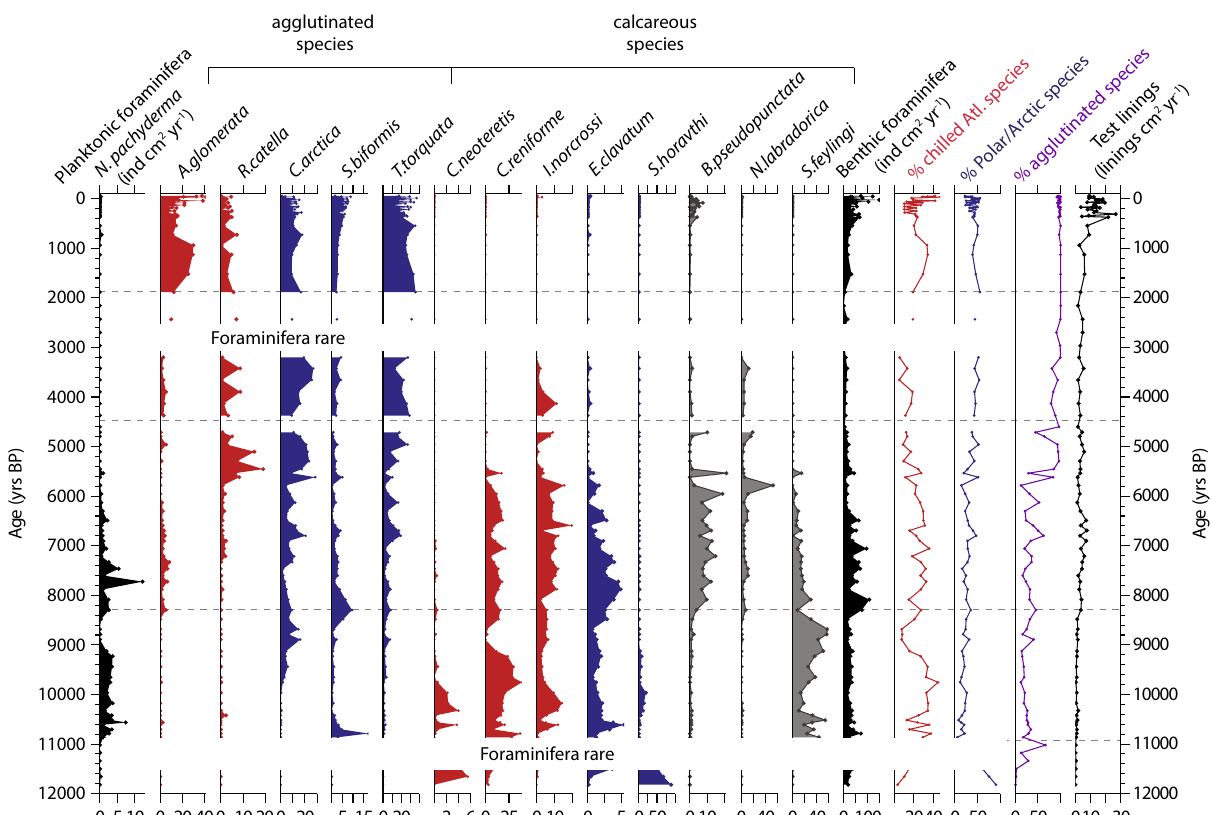
Figure 5. Foraminifera fluxes and assemblages in 117Q and 117Q BC. Planktonic foraminifera ( N. pachyderma sin.) fluxes are shown in black. Benthic foraminifera assemblages are show as percentage of the entire assemblage and colour coded according to Table 2. Only species that account for > 5% of the total assemblage in at least 1 sample are shown. Total benthic foraminifera fluxes (black) are shown as well as the overall (agglutinated and calcareous) % of chilled Atlantic water (red) and Polar/Arctic (blue) indicator benthic foraminiferal fluxes were ~ 150 ind cm 2 yr −1 , with the chilled Atlantic water group representing ca. 40% of the assemblage. Agglutinated taxa (Fig. 5) represented between 16–35% of the total benthic foraminifera assem- blage between ~ 11,900 and 8300 yrs BP, with the exception of a peak contribution (70%) ~ 11,000 yrs BP (Fig. 5). From 8300–4500 yrs BP the proportion of agglutinated species increased but was highly variable (25–95%). From 4500 yrs BP to present agglutinated taxa accounted for nearly 100% of the assemblage. Foraminifera test lining fluxes in 117Q and 117Q BC varied between 0–27 linings cm 2 yr −1 and remained low until ~ 600 yrs BP. Linings were largely of planispiral (types II and IV) and trochospiral (type I) forms 41 . In CASQ1, planktonic foraminiferal fluxes were low (< 2–12 ind cm 2 yr −1 ) from ~ 3800–2000 yrs BP with the exception of a peak at 2900 yrs BP (Fig. 6). Benthic foraminiferal fluxes were variable (4–> 150 ind cm 2 yr −1 ) and assemblages were dominated by S. feylingi (47–75%) (Fig. 6). Despite the presence of some chilled Atlantic water species ( C. reniforme = 15%) and Polar/Arctic species ( E. clavatum = 7.5%), the overall proportion of indicator groups remained low (< 20%). From 2500–2000 yrs BP both planktonic and benthic foraminiferal fluxes were too low for assemblage counts. After 2000 yrs BP, proportions of B. pseudopunctata (up to 20%) and N. labra- dorica (~ 15%) increased. The appearance of A. glomerata (< 10%) and R. catella (up to 20%) at ~ 2000 yrs BP accounts for an increase in the chilled Atlantic water group. From 800 to 200 yrs BP, there was little variation in assemblage composition. In the last ~ 60 yrs, benthic foraminiferal fluxes increased (~ 200 ind cm 2 yr −1 ) and the Polar/Arctic water group species (agglutinated) became increasingly dominant (50%). The calcareous species N. labradorica and B. pseudopunctata were present in relatively low abundances (~ 5 to 15%). The proportion of agglutinated species in CASQ1 was between 10–30% from 3800 to 1800 yrs BP and 40–85% after 1800 yrs BP (Fig. 6). Foraminifera test lining fluxes in CASQ1 and CASQ1 BC varied between 0–40 linings cm 2 yr −1 and were mostly of planispiral (types II and IV) and trochospiral (type I) forms 41 . Foraminifera test linings fluxes increased between ~ 2000–1000 yrs BP and during the last ~ 50 years. Lipid biomarkers. In 117Q, IP −1 , 25 concentrations normalised to TOC ranged from 2.25–13.65 µg g TOC peaking between 550–510 cm (~ 11,177–9965 yrs BP), and increased again in the top 30 cm of the core (last ca. 232 yrs BP) (Fig. 7). HBI III (triene) was either absent or present in low concentrations (≤ 0.33 µg g TOC −1 ) in the lower sections of 117Q, and concentrations were consistently higher (> 0.33–4.3 µg g TOC −1 ) in the top 100 cm of the core, with a sharp increase after ca. 1800 yrs (Fig. 7).